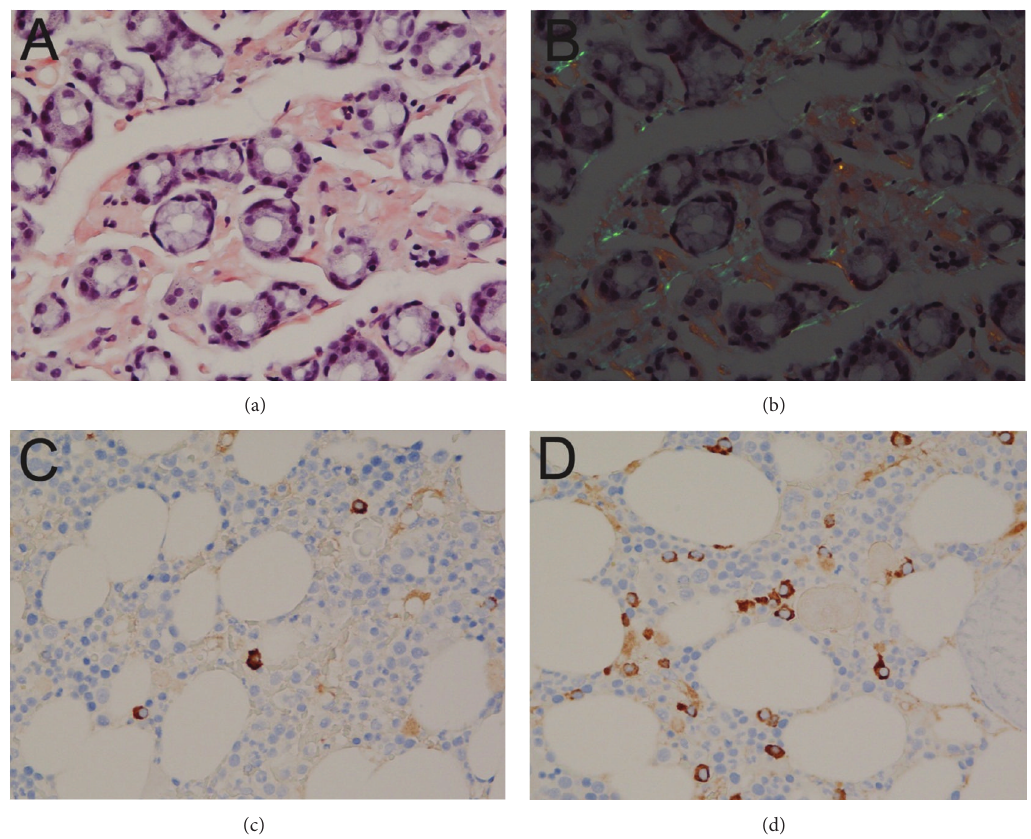
Figure 2: Biopsies from the gastric corpus stained with Congo red, with extracellular deposits between the gastric glands (a) and apple- green birefringence seen under polarized light (b). Immunohistochemical examination of a bone marrow biopsy showed a normal density of immunoglobulin kappa ( 𝜅 ) chain (c) and an increased density of immunoglobulin lambda ( 𝜆 ) chain positive cells